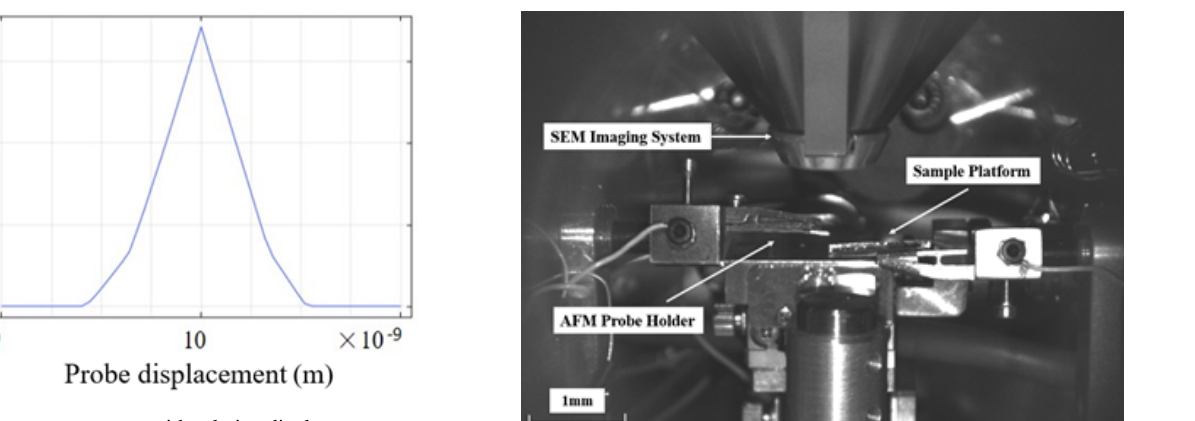
Figure 7. Contact stress curve with relative displacement.